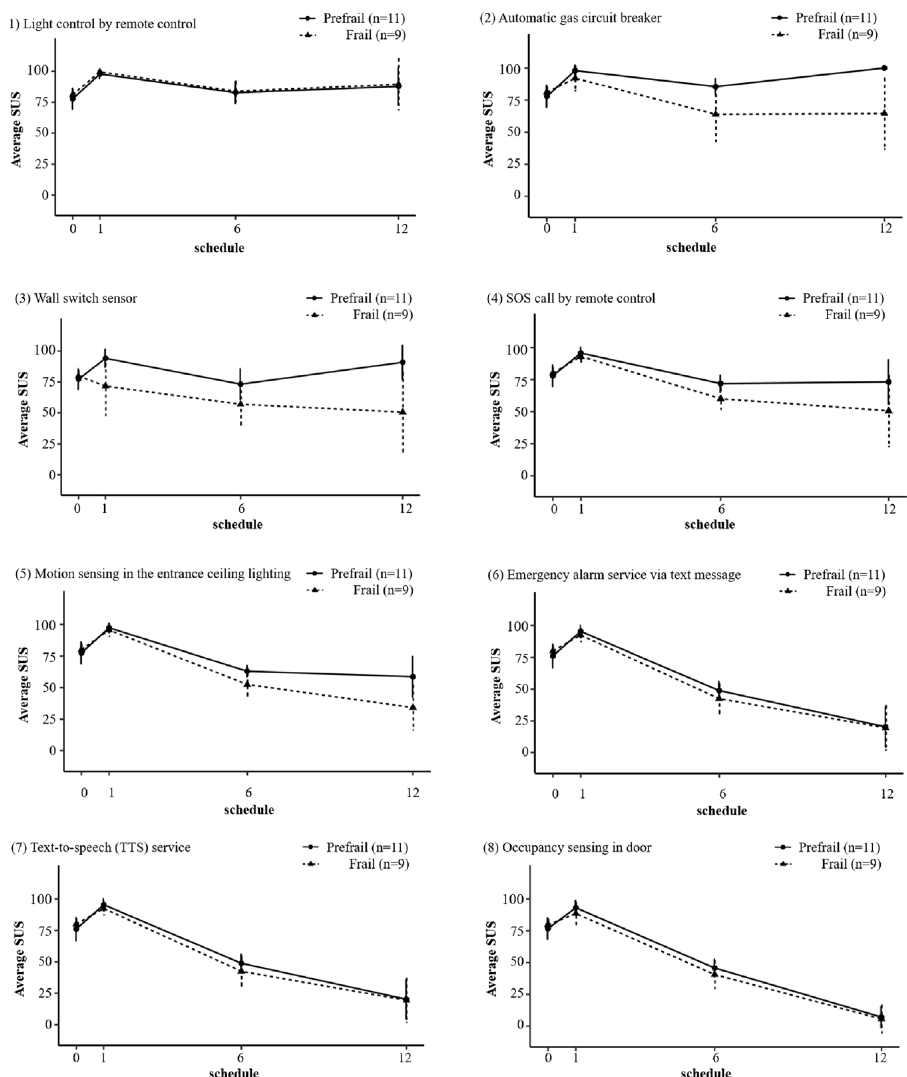
Figure 3. Service-specific system usability scale by frailty status. The usability pattern was different according to the type of services. Light control by remote controller showed consistently high usability both in the prefrail and frail group. Certain services such as automatic circuit breaking, light control by wall switch sensor, SOS call by remote controller, and motion sensing by the sensor in the entrance ceiling lighting showed a down slope in both groups, but relatively higher in prefrail group. Usability of the emergency text alarm service, text-to-speech service, and occupancy sensing by the door sensor decreased steadily both in the prefrail and frail group. SUS System Usability Scale. Data preprocessing was conducted by using Python software, version 3.6.8 (The Python Software Foundation, DE, USA), URL https:// www. python. org, and the figure was created by using R